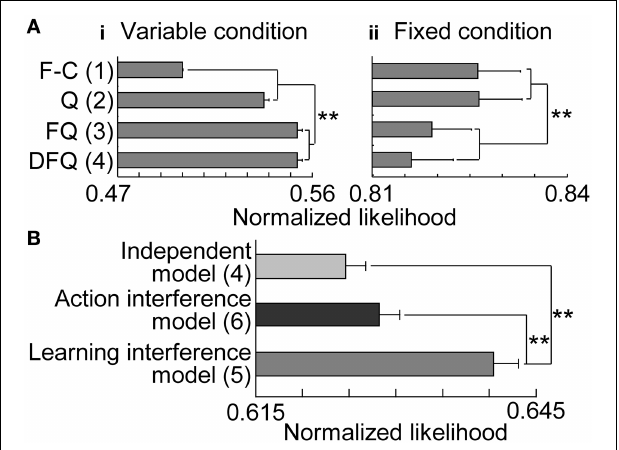
FIGURE 6 | Model fitting. (A) Trials with variable- (i) and fixed-reward conditions (ii) . Results of 2-fold cross validation were compared among the four models: F-C, fixed-choice model; Q: standard Q-learning; FQ: forgetting Q-learning; DFQ: differential forgetting Q-learning. Means and standard errors are shown. The number of free parameters in each model is shown in parentheses: ∗∗ p < 0 . 01 in a two-sided paired t -test. (B) All trials. FQ-learning and fixed-choice models were employed as learning rules of variable- and fixed-reward conditions, respectively.